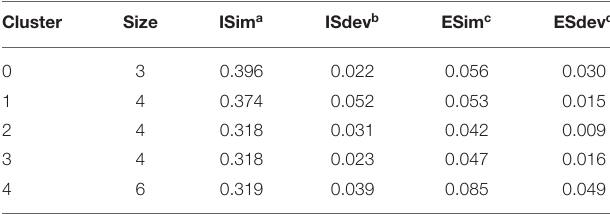
TABLE 2 | 5-way clustering